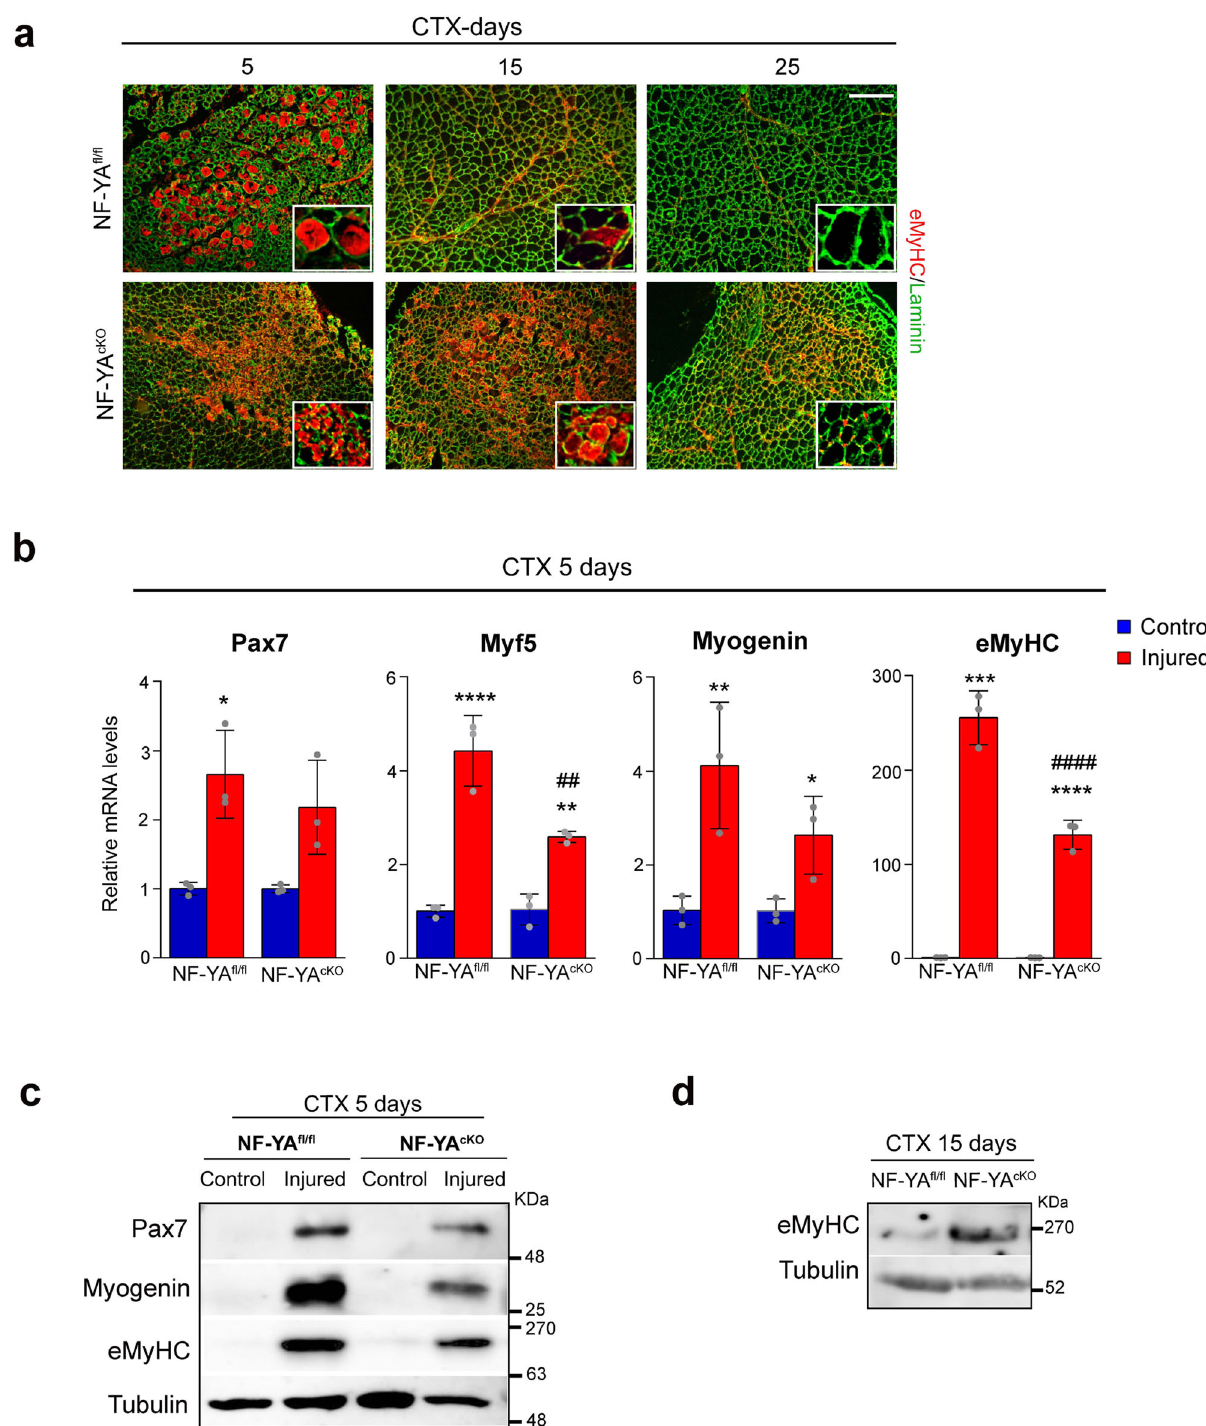
Fig. 2 Loss of NF-YA delays regenerative myogenesis in vivo. a Representative immunostaining for eMyHC (red) and laminin (green) on TA muscle sections of NF-YA fl / fl and NF-YA cKO mice 5, 15 and 25 days after CTX injury. Nuclei were identi fi ed by DAPI staining. Scale bar: 100 µ m. b Relative mRNA levels of myogenic markers Pax7, Myf5, Myogenin, eMyHC in whole 5-days injured TA muscles of NF-YA fl / fl and NF-YA cKO mice measured by RT-qPCR. Transcript levels of NF-YA fl / fl and NF-YA cKO uninjured mice have been arbitrarily set at 1. Data represent mean ± s.d. (one-Way Anova: Pax7 F(3,8) = 9.66, p = 0.0049; Myf5 F(3,8) = 44.63, p < 0.0001; MyoG F(3,8) = 9,99, p = 0.0044; eMyHC F(3,8) = 170.8, p < 0.0001; n = 3 mice per group. * p < 0.05, ** p < 0.01, *** p < 0.001, **** p < 0.0001 vs control; ## p < 0.01, #### p < 0.0001 vs NF-YA fl / fl ). c Western blot analysis performed on whole protein extracts of uninjured (control) and 5-days injured TA muscles of NF-YA fl / fl and NF-YA cKO mice. Immunoblots represent protein levels of Pax7, eMyHC, Myogenin and Tubulin. n = 3 experiments. d Western blot analysis of eMyHC on whole protein extracts of 15-days injured TA muscles of NF-YA fl / fl and NF-YA cKO . Tubulin was used as loading control. n = 3 experiments.